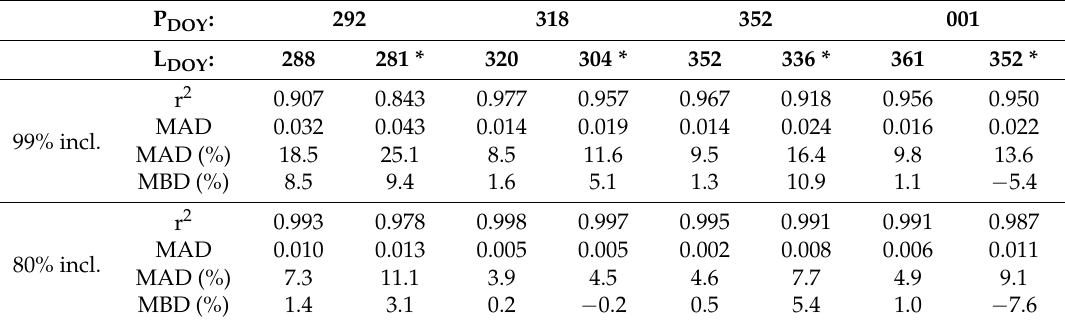
Table 2. Statistical metrics of the agreement in NDVI between four Planet acquisition days (P DOY ) and near-coincident (i.e., left columns) Landsat-8 acquisitions (L DOY ). Landsat NDVI close to (0–5 days) or further away (11–16 days) from P DOY was used to train the Cubist regression models. In the latter case, MODIS NDVI was used to inform on any change occurring between L DOY and P DOY . The statistics are based on Planet data resampled to 30 m, and are reported for the full set of data points (i.e., 99%) in addition to a reduced set incorporating 80% of the data.